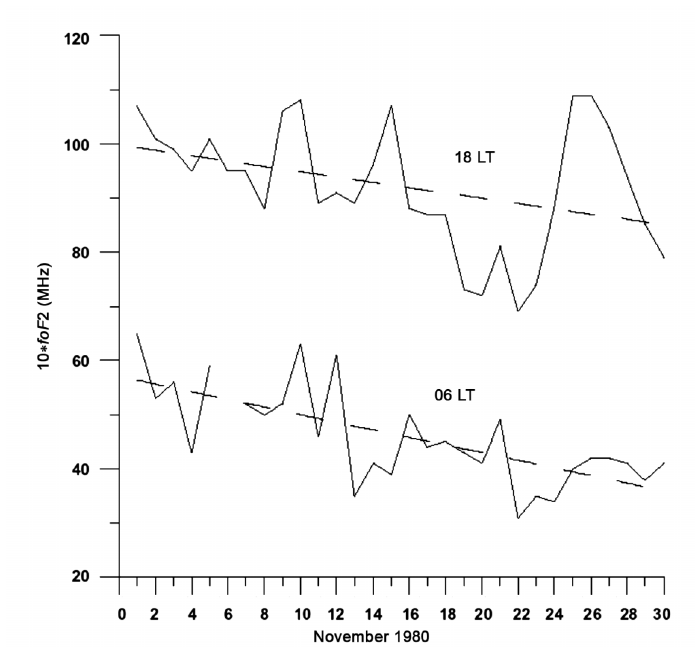
Fig. 10. Critical frequency for 06:00 LT and 18:00 LT for November 1980 (Rome ionospheric station). Dashed lines show the seasonal trend of the critical